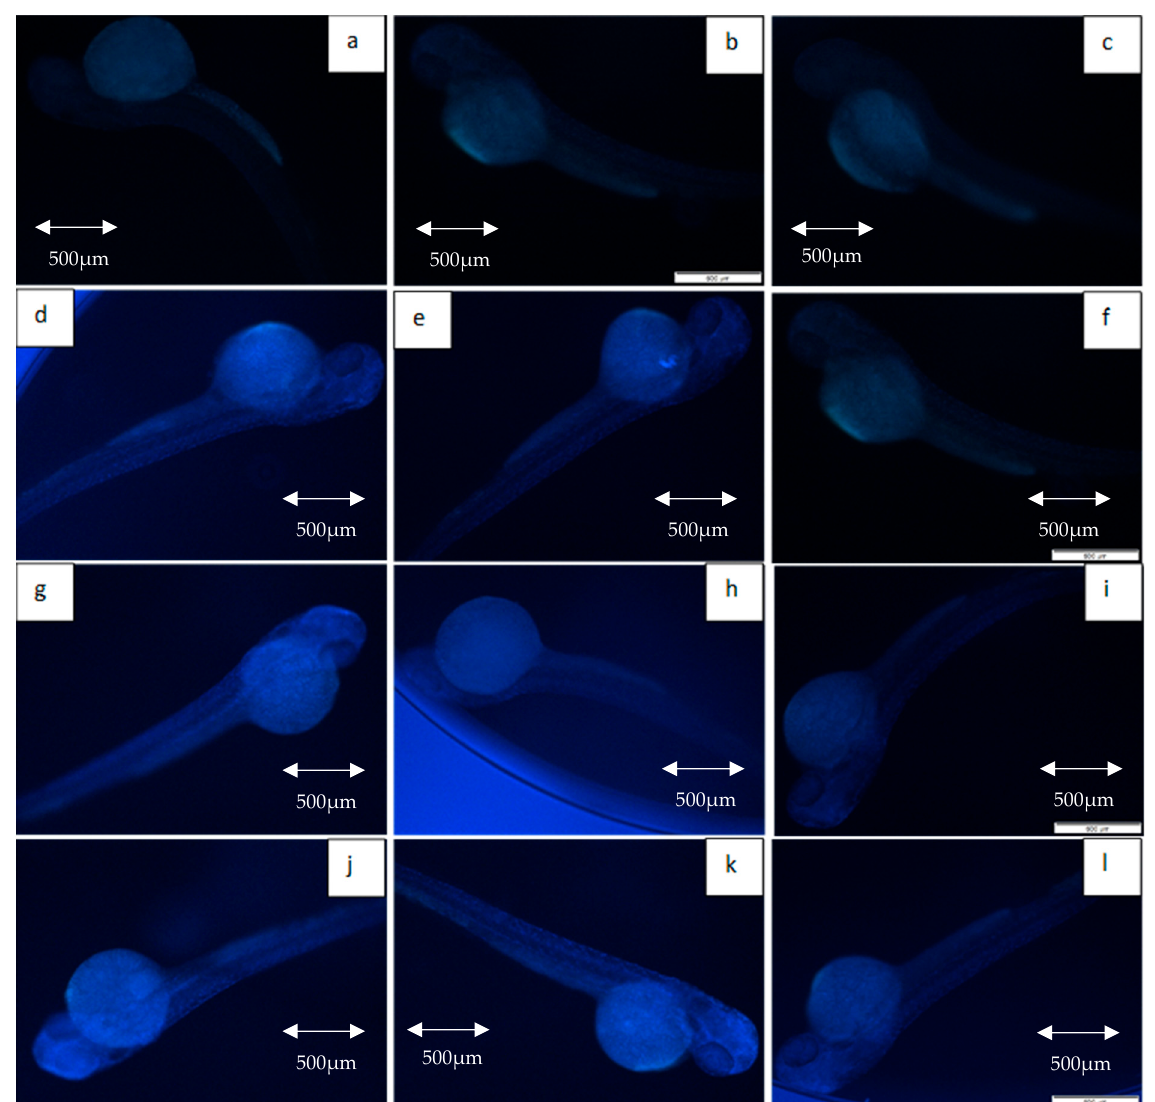
Figure 9. Expression of caspase ‐ 3 in non ‐ irradiated and irradiated zebrafish embryos. ( a ) Control without any treatment (non ‐ irradiated); ( b ) control pre ‐ treated with KH (non ‐ irradiated); ( c ) control pre ‐ treated with amifostine (non ‐ irradiated); ( d ) untreated embryos irradiated at 11 Gy; ( e ) embryos pretreated with KH and irradiated at 11 Gy; ( f ) embryos pretreated with amifostine and irradiated at 11 Gy; ( g ) untreated embryos irradiated at 15 Gy; ( h ) embryos pretreated with KH and irradiated at 15 Gy; ( i ) embryos pretreated with amifostine and irradiated at 15 Gy; ( j ) untreated embryos irradiated at 20 Gy; ( k ) embryos pretreated with KH and irradiated at 20 Gy; ( l ) embryos pretreated with amifostine and irradiated at 20